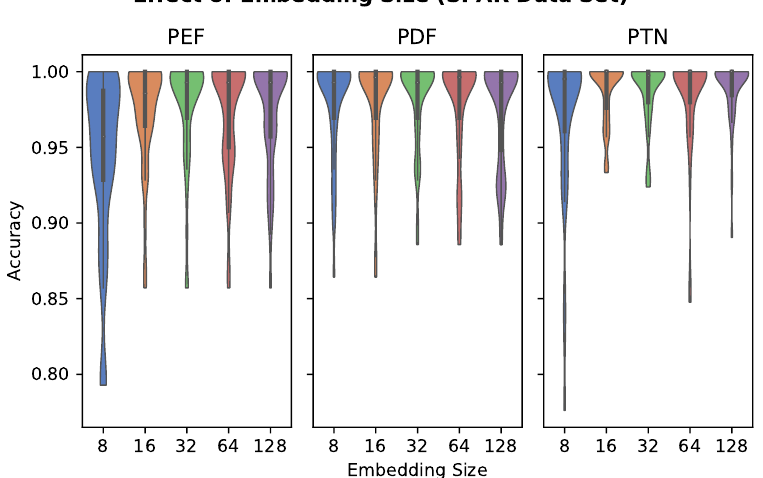
Figure 3. The effect of embedding size (number of features) on personalized feature classifier accuracy, evaluated on the SPAR dataset. The performance of the PEF model appears to degrade at embedding size 16 and below.